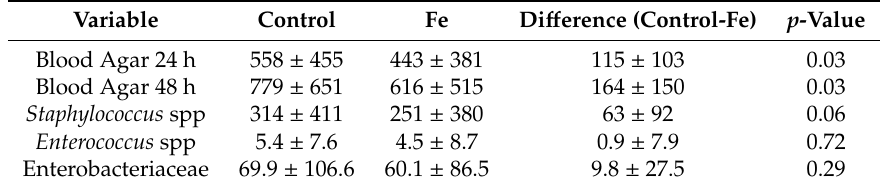
Figure 6. Culture on sheep blood agar [a: control group (C), b: iron oxide group (Fe)]. Reduction of the microbial load after 24 h of incubation (37 °C). Table 2. Microorganisms (cfu / mL) isolated from boar semen samples 24 h and 48 h after incubation on blood agar and selective culture media.